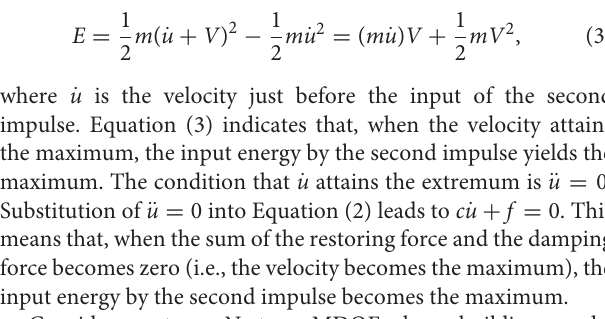
2016; Saotome et al., 2018; Shiomi et al., 2018). This is due to